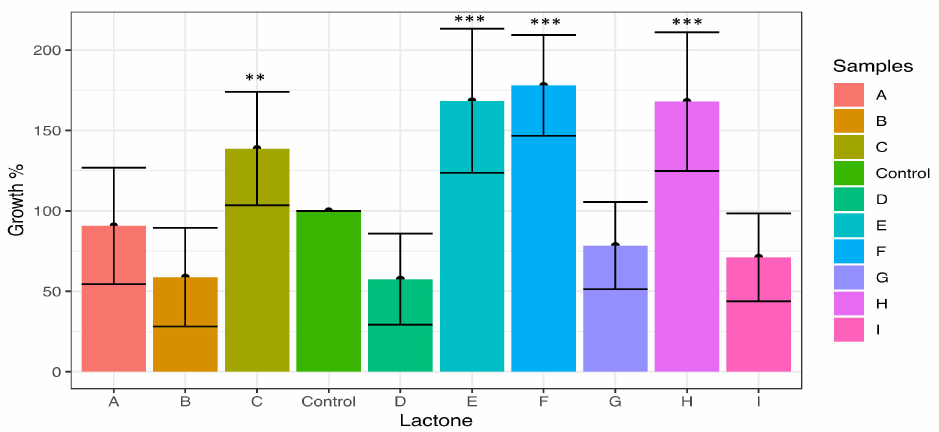
Figure 2. Effects of lactones in cell proliferation of M. aeruginosa with nine homoserine lactones, N3-oxodecanoyl ( A ), N-(3-oxododecanoyl) ( B ), N-hexanoyl ( C ), N-decanoyl ( D ), N-heptanoyl ( E ), N-dodecanoyl ( F ), N-octanoyl ( G ), N-(3-oxooctanoyl) ( H ), and N-butyryl-L-homoserine lactone ( I ) after 72 h of exposure. The red line indicates the level of proliferation in the control experiment. Powerful inducers of cell proliferation were lactones E, F, and H that induce a proliferation close to 75% of the control, while lactones B and D reduce this proliferation by almost 50% exposure. Whiskers are standard deviations. **, p < 0.01; ***, p <